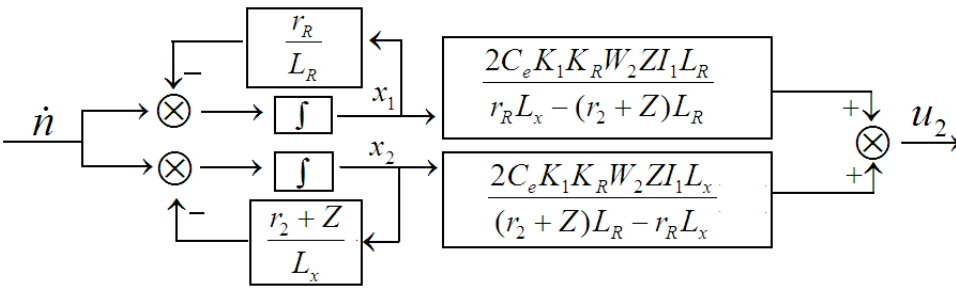
Figure 7. The state variables scheme of